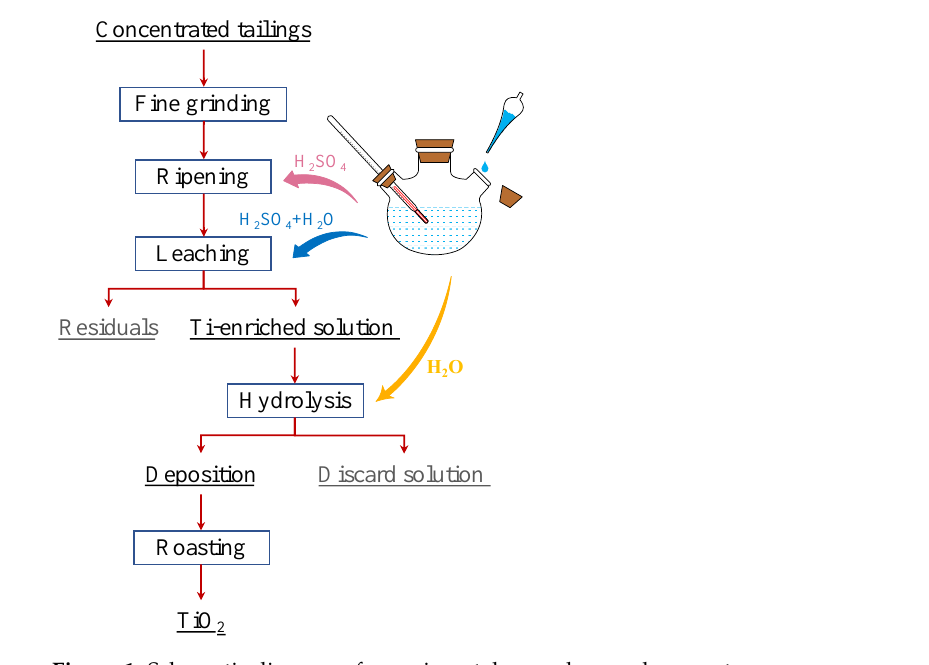
Table 2. Chemical composition of the Ti-bearing slag (mass%).